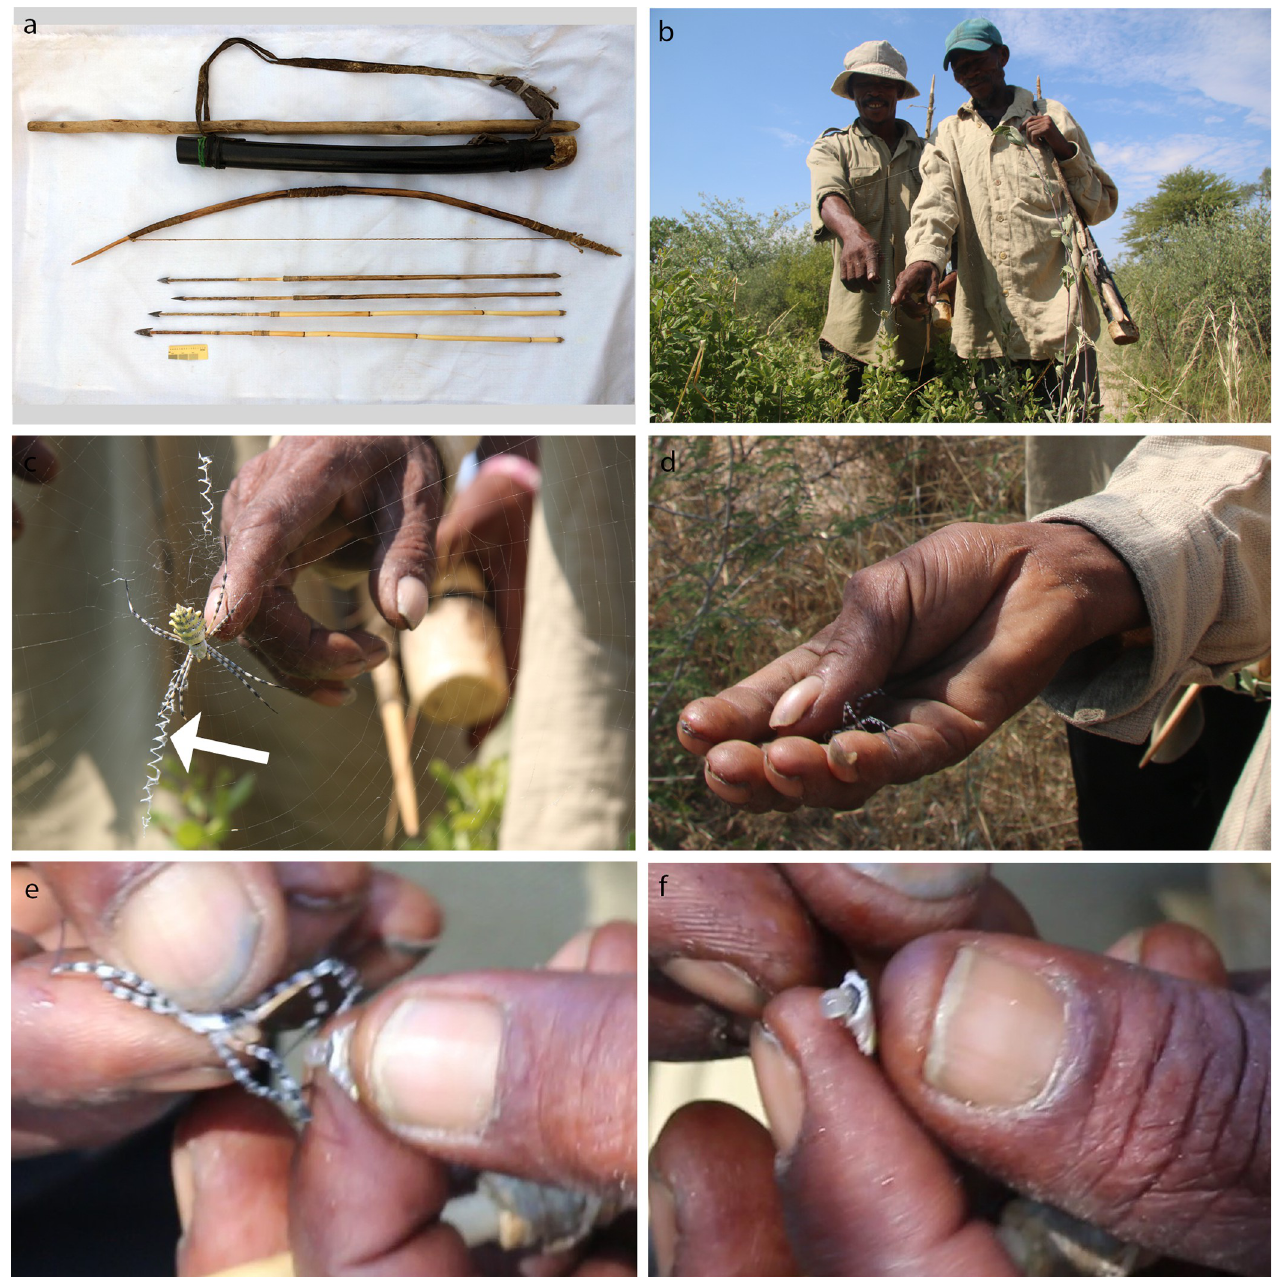
Fig 6. Argiope australis (Walckenaer 1805) (Araneidae), the garden orb-web spider, used as arrow poison by G/ui and G//ana San, Central Kalahari Game Reserve (CKGR), Botswana. a. Example of a hunting kit used by the G/ui and G//ana San in the CKGR (photo: C.S. Chaboo). b. Informants Mohame Belesa (left) and Kalakala Tshenehe (right) point to the spider A . australis in its web. c. Female A . australis in the centre of its web (note the zig-zag pattern of the stabilimentum, indicated with an arrow). d. Informant holds the spider after he removed it from the web. e. The prosoma is separated from the opisthosoma (‘abdomen’), before discarding the former. f. The content of the opisthosoma is applied to the arrow as sole ingredient of the poison (photos: T.L. Bird, unless otherwise